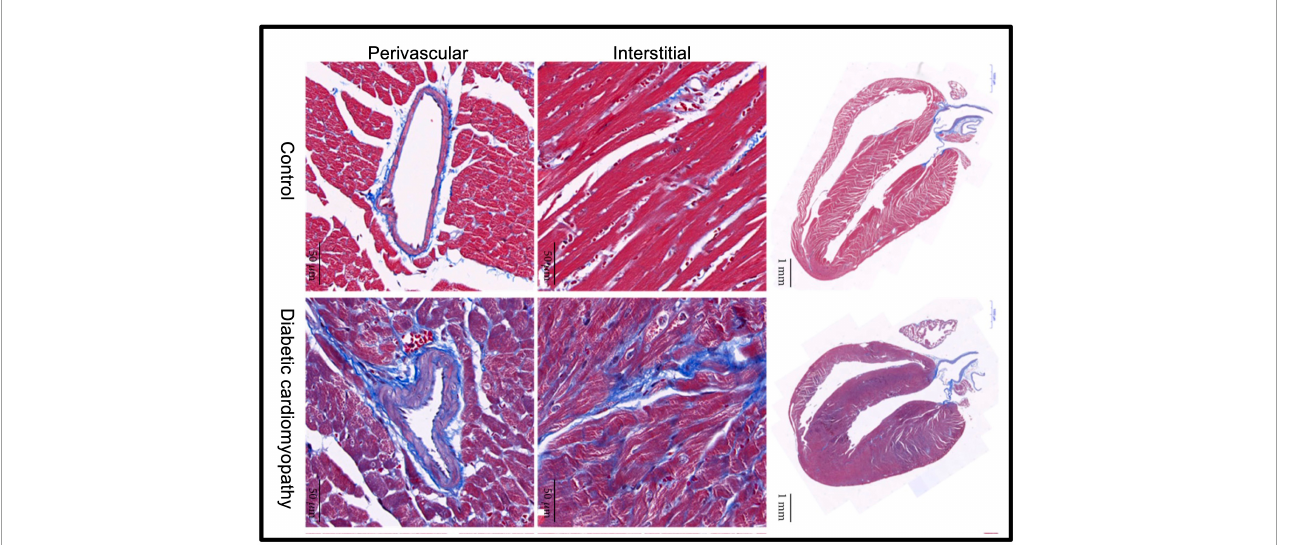
FIGURE1 Fibrosis plays a crucial role in the development of diabetic cardiomyopathy. Representative images of Masson’s trichrome staining of a longitudinal section of the heart of control and diabetic mice (scale bar 1 mm). Magnified views show extracellular collagen deposition in the interstitial (scale bar 50 µ m) and perivascular (scale bar 50 µ m) space. Compared to the control group, diabetic cardiomyopathy mouse hearts displayed markedly increased collagen content both in the interstitial and perivascular space. Adapted from Li et al. with permission